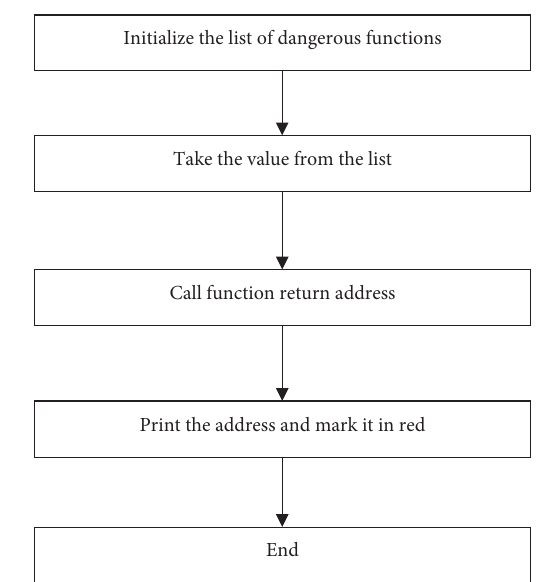
Figure 4: Flowchart of the ultrasonic data acquisition